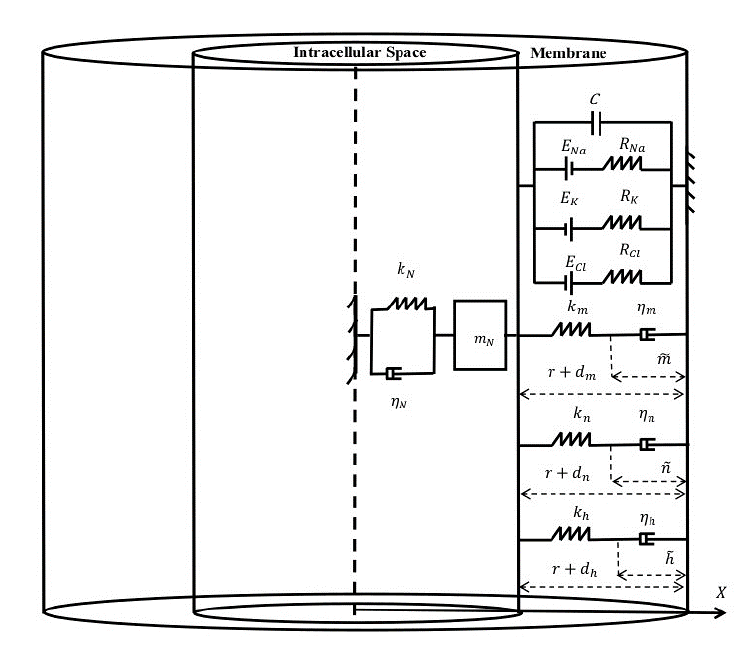
Figure 2. Schematic of the electromechanical model of a neuron and its membrane: the neuron is a homogeneous axi- symmetric circular cylinder whose inner core is filled with the intracellular space and the outer layer is the membrane. Because of the geometrical symmetry and material homogeneity, it is enough to study half of the neuron modelled as a spring-dashpot-mass mechanical system with the spring and dashpot connected in parallel (linear viscoelastic Kelvin-Voight element). The membrane is represented as an electrical circuit described by the Hodgkin-Huxley equations where the ionic gates 𝒎, 𝒏, and 𝒉 are modelled as linear viscoelastic Maxwell elements connected in parallel. In what follows, we denote the first order derivative with respect to the time variable 𝑡 of a generic differentiable function 𝑓(𝑡) by either 𝑓̇ or 𝑑𝑓/𝑑𝑡 .